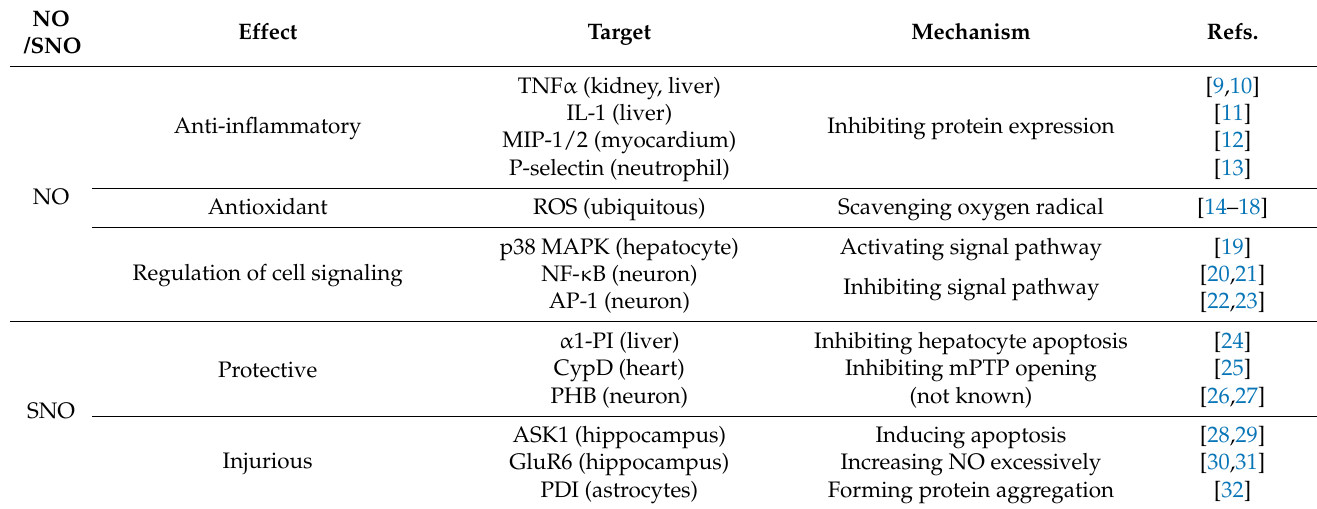
Table 1. Role of nitric oxide and protein S-nitrosylation and their targets in ischemia-reperfusion